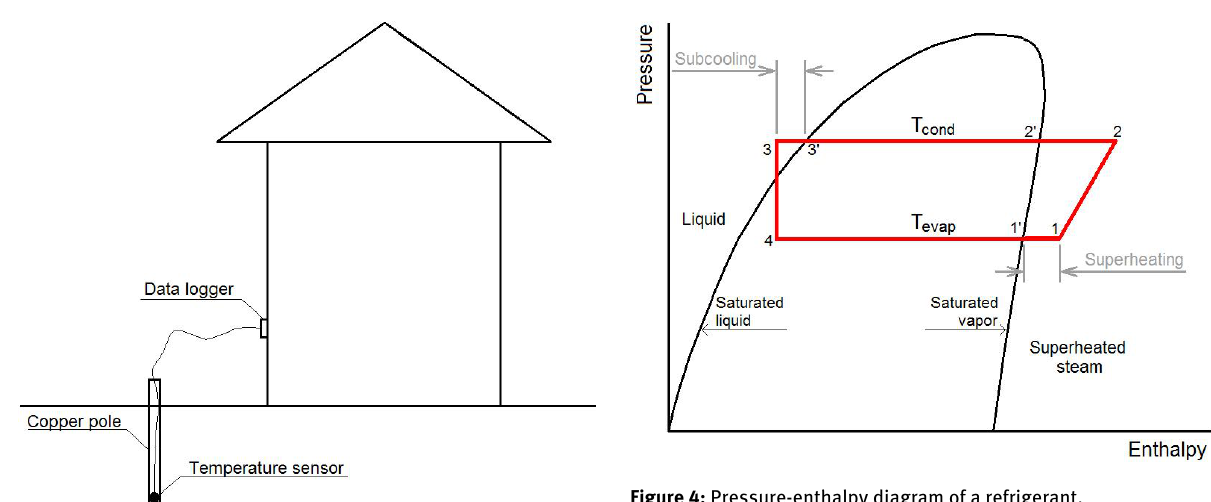
tended for temperature control of cooling systems in con- junction with electronic controllers also manufactured by the company. Figure 3 shows the sensor protected with a PVC film and the sensor-tube assembly installed on the ground.